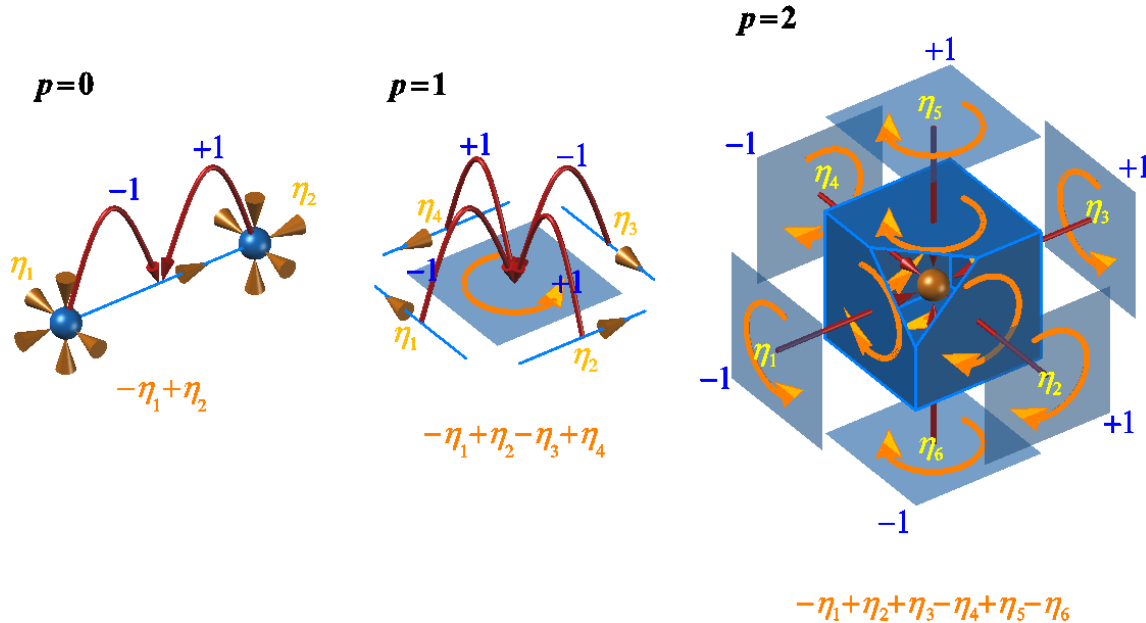
Figure 1: How to find the weight of a ( p + 1)−cell starting from the weights of its faces.